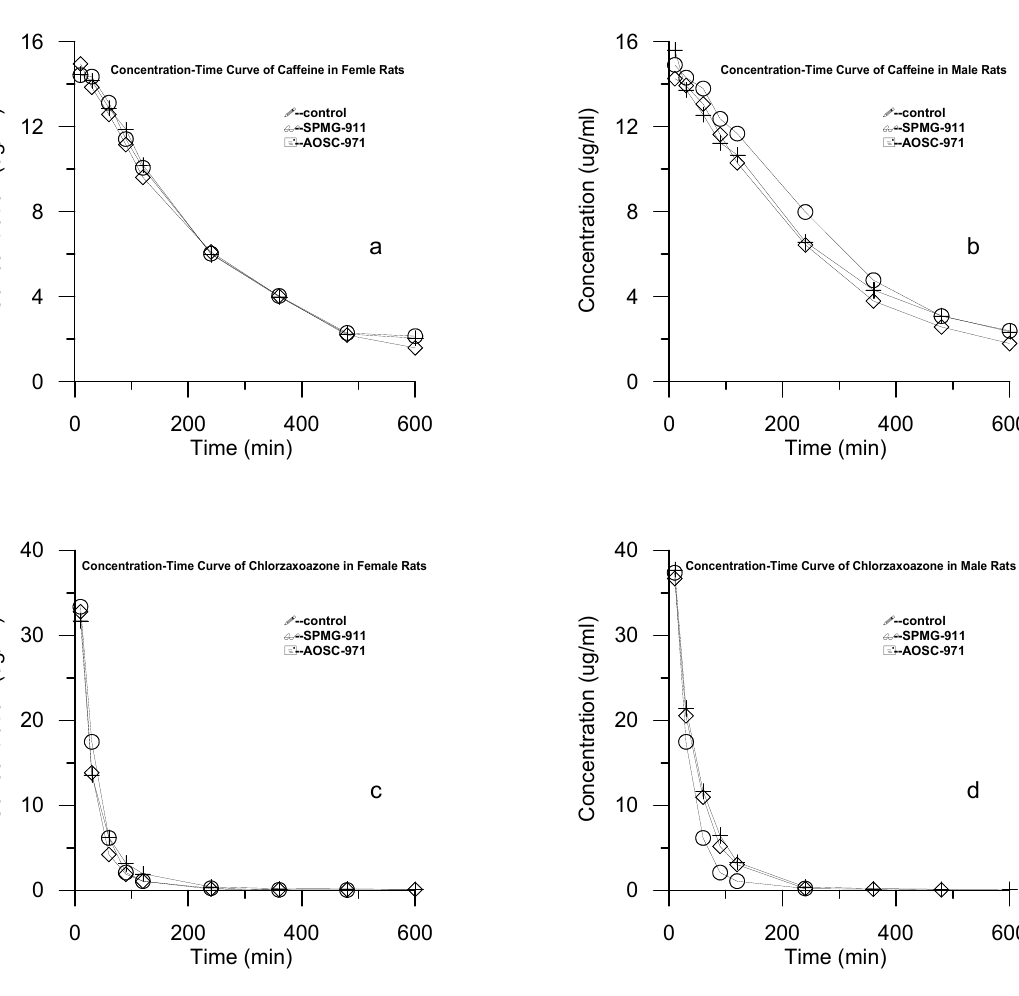
Figure 1. Concentration-Time Curves of: a) caffeine in female rats; b) caffeine in male rats; c) chlorzoxazone in female rats; d) chlorzoxazone in male